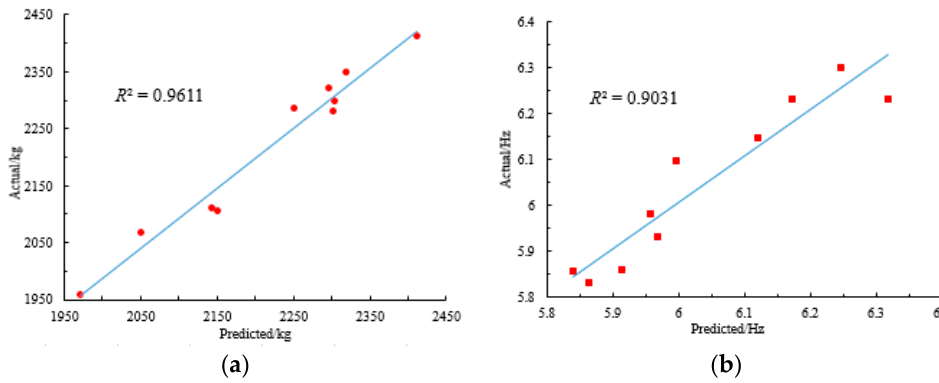
Table 4. Determination coefficients of surrogate models.